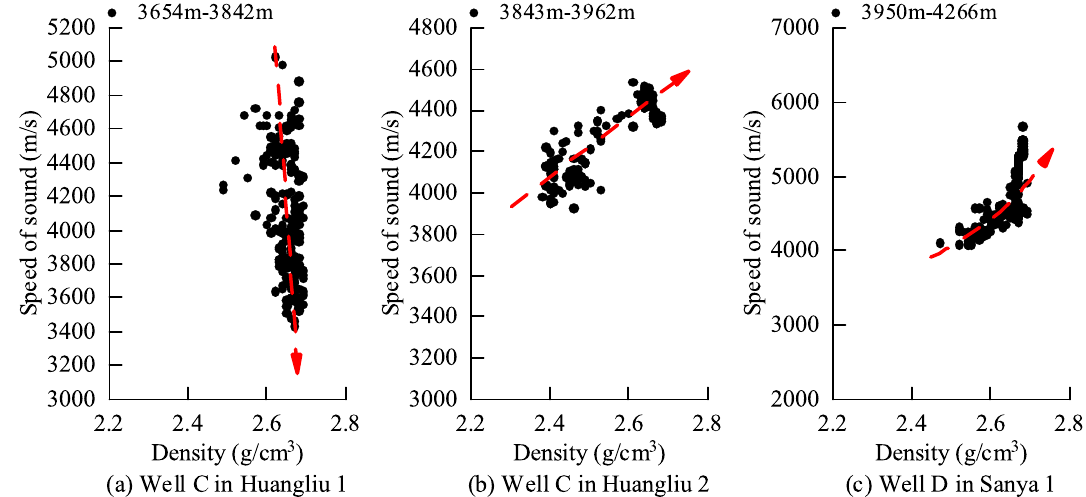
Figure 3. Abnormal pressure identification of some wells in the Yacheng